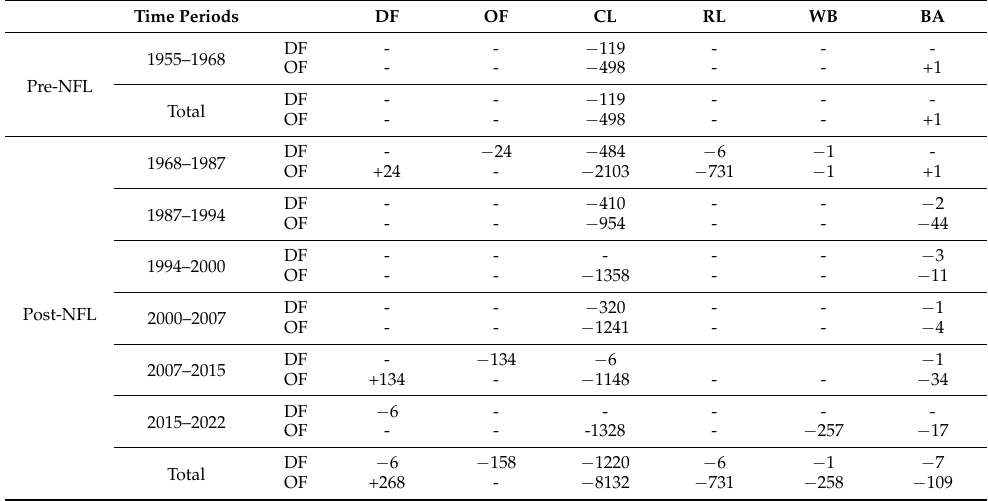
Figure 7. Net changes (ha) for each land use class during the studied time periods. Legend: DF—dense forest, OF—open forest, BA—built-up areas, CL—croplands, RL—rangelands, WB—waterbodies, BL—barren lands. Table 6. Major change trajectories (ha) from forestlands (dense and open forests) to other types of land use classes in studied time periods.